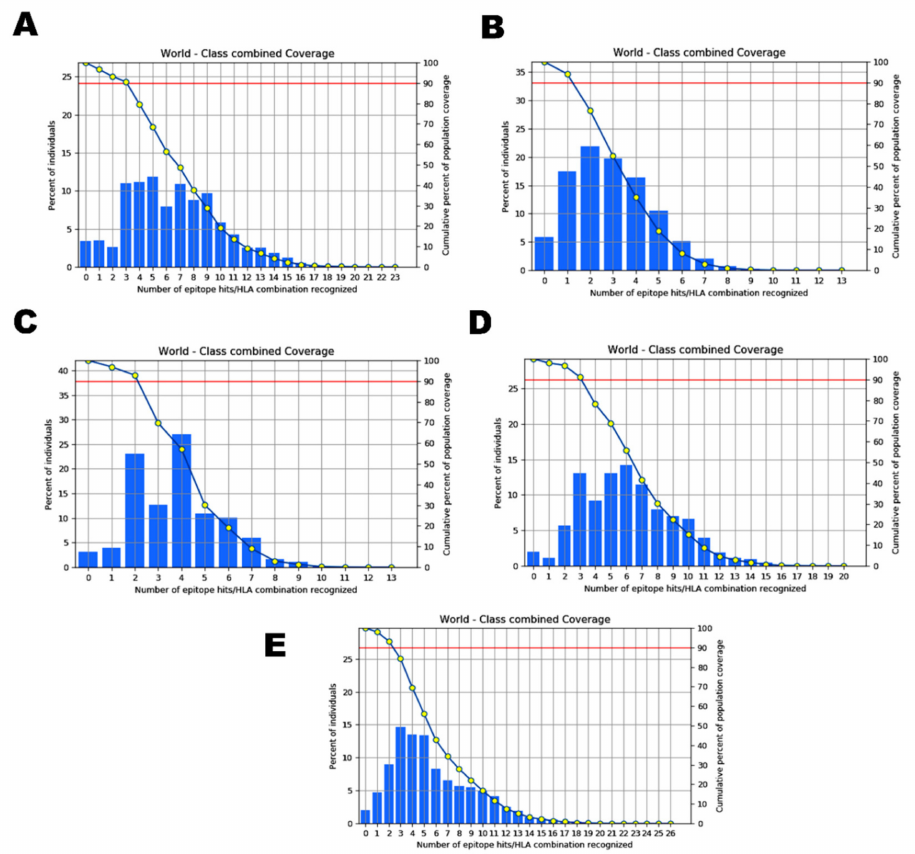
Figure 4. Graphs depicting the world population coverage of the spike glycoprotein of SARS-CoV-2 variants isolated from ( A ) Wuhan, China, ( B ) England, ( C ) the USA, ( D ) India, and ( E ) South Africa to the MHC I and II alleles